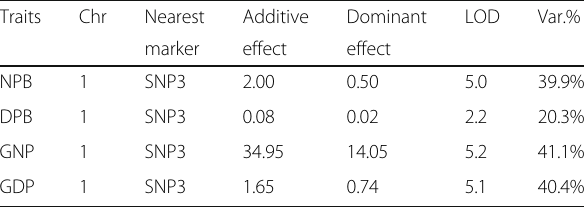
Table 3 Effects of the QTL (in the interval SNP1-SNP5) on yield- related traits detected in the random subpopulation BC 3 F 2 -LQ96 derived from BC 3 F 1 -22F01 using Kongyu 131 as the recurrent parent and GKBR as the donor